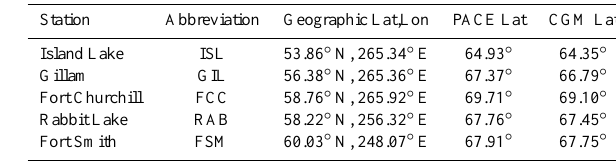
Table 1. Geographic latitude and longitude and PACE invariant geomagnetic latitude (Baker and Wing, 1989) of the CANOPUS stations that produced data used in this